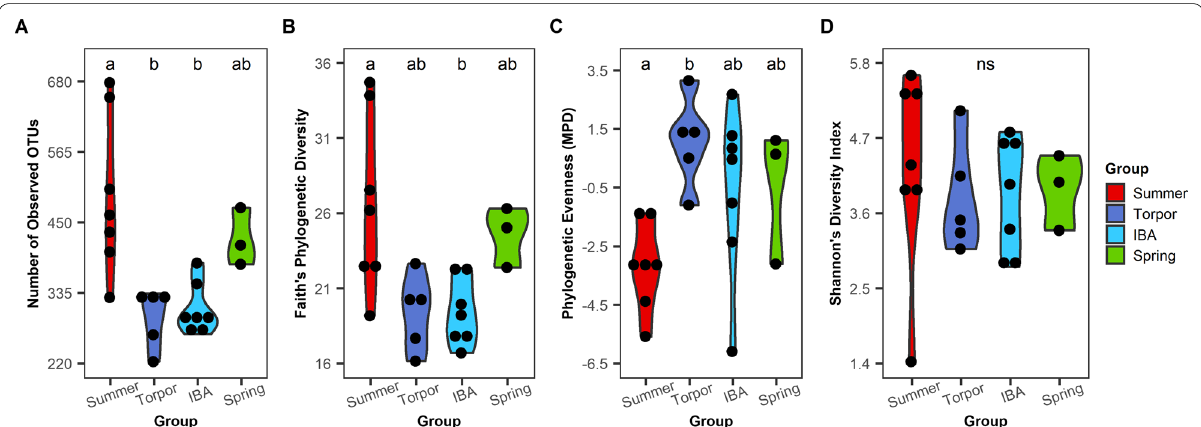
Fig. 3 Alpha diversity comparison among mucosa microbiotas of captive groups. Violin plots display four alpha diversity metrics: A the number of observed OTUs, B Faith’s phylogenetic diversity, C phylogenetic evenness (MPD), and D Shannon’s diversity. Groups that share a letter are not significantly different (adj P > 0.05), whereas groups that share no letters are significant different (adj P < 0.05). Metrics with no significant comparisons among groups are indicated with “ns.” Adjusted p -values were calculated from ANOVA and Tukey’s HSD tests, or from Kruskal–Wallis and Dunn’s tests, depending on data